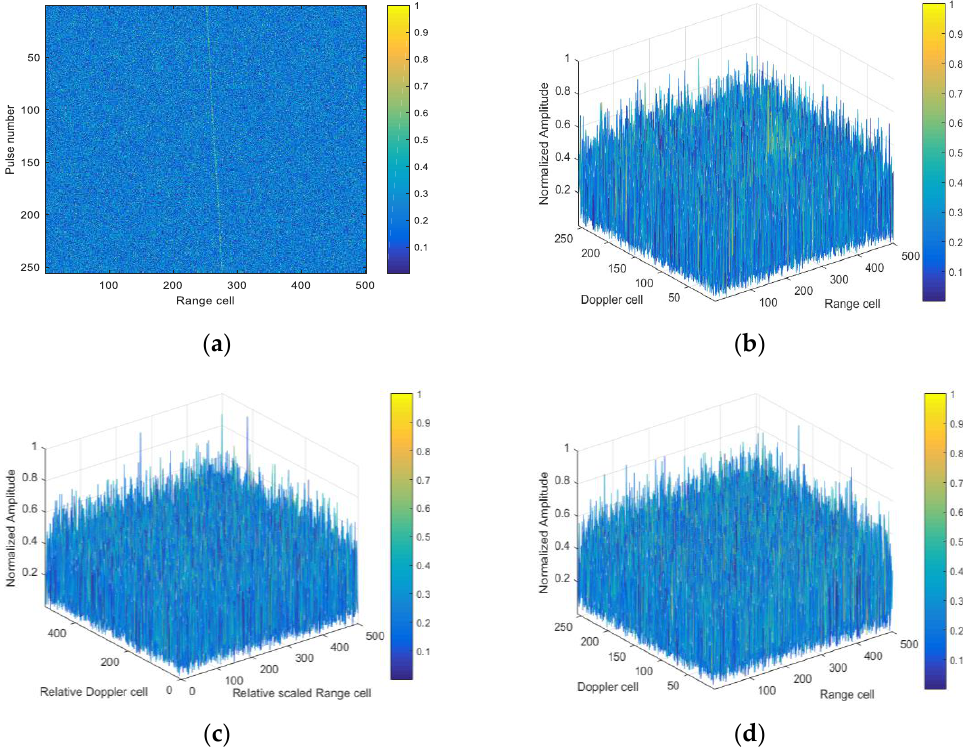
Figure 6. Coherent integration for a maneuvering target. ( a ) The result after pulse compression; ( b ) the integration result of moving target detection (MTD); ( c ) the velocity estimation result of the scaled inverse Fourier transform (SCIFT); ( d ) the integration result of the SCIFT.